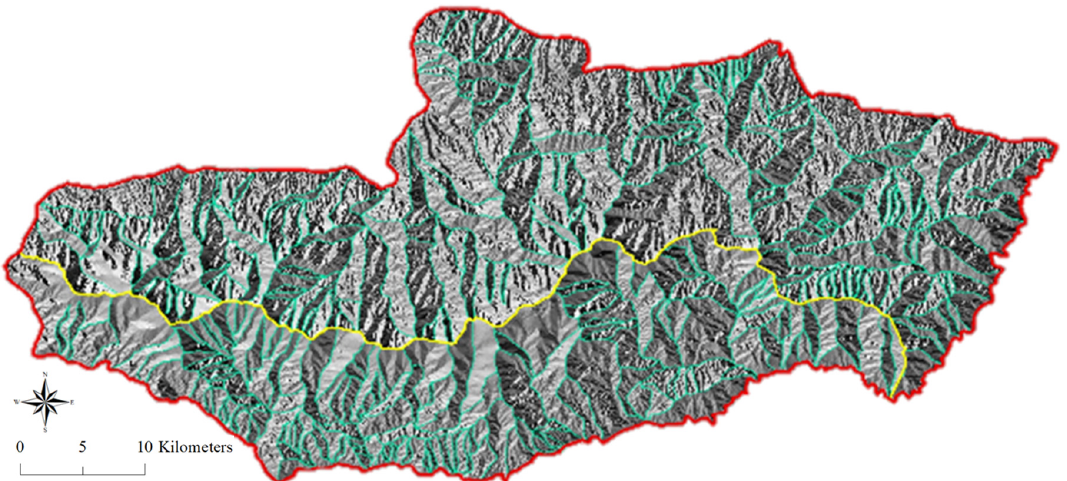
Figure 5. North–south slope division and topographic partitioning based on topographic data (The red line around indicate the whole study area. The yellow line in the middle is the dividing line between the south slope and the north slope of Taibai Mountain. The light green lines are the extracted ridge and valley lines in the study area).